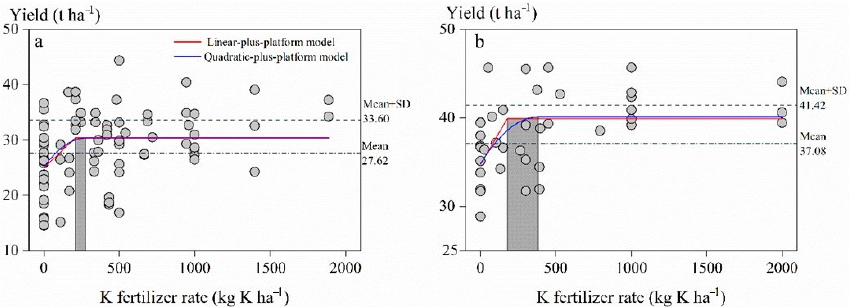
Figure 2. The functional relationship between apple yield and K application rates in Loess Plateau ( a ) and Bohai Bay ( b ) of China. Loess Plateau: y = –6.83 × 10 –5 x 2 + 0.0378 x + 25.0911 x < 276.93, y = 30.33 x ≥ 276.93 (quadratic-plus-platform model) and y = 0.026 x + 24.97 x < 208.33, y = 30.39 x ≥ 208.33 (Linear-plus-plateau model). Bohai Bay: y = –3.594 × 10 –5 x 2 + 0.0275 x + 34.83355 x < 382.653, y = 40.096 x ≥ 382.653 (quadratic-plus-platform model) and y = 0.029 x + 34.766 x < 176.614, y = 39.888 x ≥ 176.614 (Linear-plus-plateau model). Shadow areas represented the difference of K-fertilizer application rate (long side) between the quadratic plus platform and linear plus platform model under the scenario of predicting almost equivalent yields (broadside). Mean, average yield of apple field with K-fertilizer; SD, standard deviation.